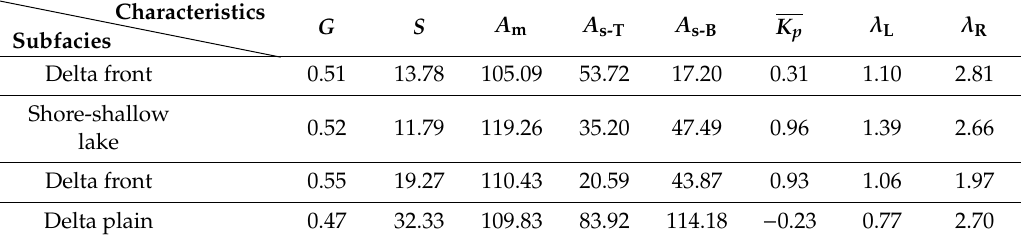
Table 1. Sedimentary characteristics of log curves and corresponding subfacies in the study area